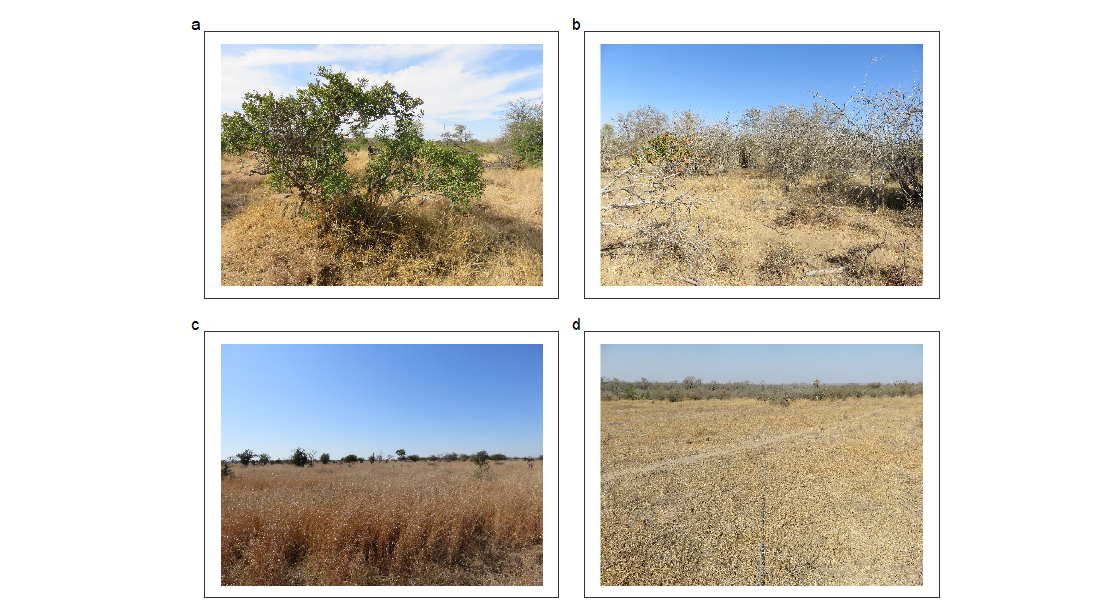
Figure 2. Examples of Plant Functional Types (PFTs): ( a ) woody evergreen, ( b ) woody deciduous, ( c ) bunch grass and ( d ) grazing